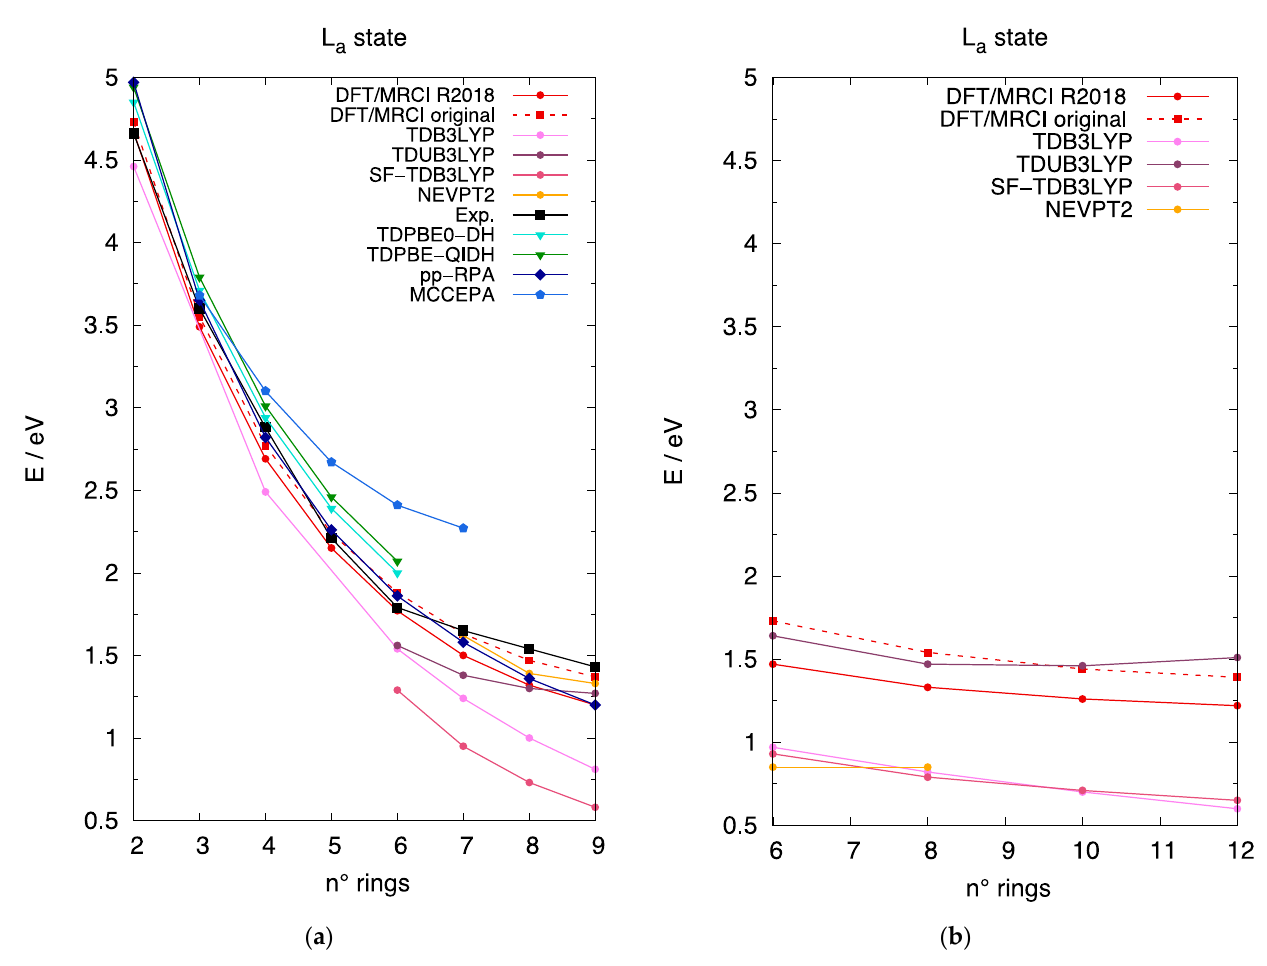
Figure 5. The excitation energy to the 𝐿 (cid:3028) state (i.e., the state dominated by the HOMO → LUMO excitation) described for different computational approaches. The excitation energy scale is the same in the two panels to allow a direct comparison between linear and cyclic acenes. ( a ) Excitation energy of the 𝐿 (cid:3028) state for [n]-acenes as a function of the number of rings: (red circles) DFT/MRCI R2018 parametrization; (red squares, dashed line) DFT/MRCI original parametrization; (pink circles) TDB3LYP; (purple circles) TDUB3LYP; (dark-rose circles) SF-TDB3LYP; (gold circles) NEVPT2; (black squares) experimental from refs. [16,18,19,23,40]; (cyan triangles) TDPBE0-DH from ref. [46]; (green triangles) TDPBE-QIDH from ref. [46]; (blue diamonds) pp-RPA from ref. [30]; (royal-blue pentagons) MCCEPA from ref. [18]. ( b ) Excitation energy of the 𝐿 (cid:3028) state for [ n]-CCs as a function of the number of rings: (red circles) DFT/MRCI R2018 parametrization; (red squares, dashed line) DFT/MRCI original parametrization; (pink circles) TDB3LYP; (purple circles) TDUB3LYP; (dark-rose circles) SF-TDB3LYP; (gold circles) NEVPT2.